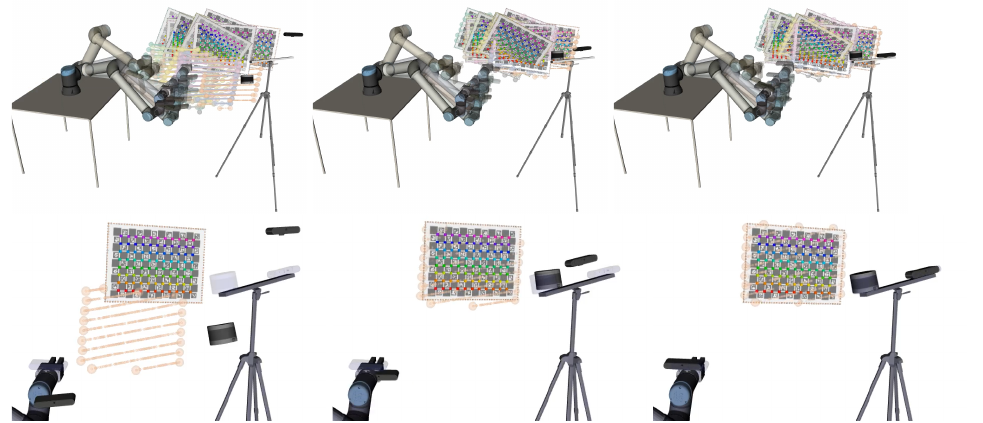
Figure 12. Visualizing the evolution of a calibration procedure from the initial estimate ( left ) to the solution ( right ). The top row shows all collections used in this calibration (different colors for each collection). The bottom row shows a single collection and, in transparent mode, ground truth poses of the sensors (known because this dataset was generated in